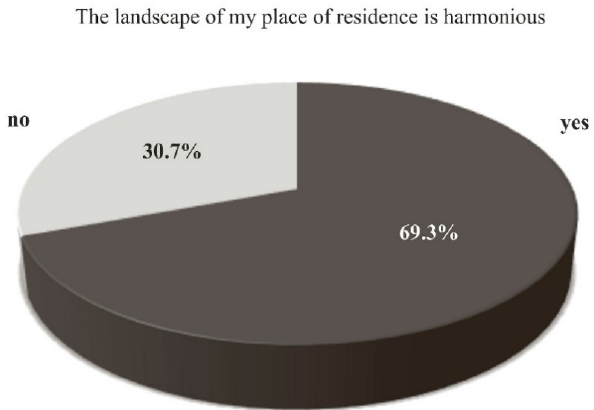
Figure 6. General assessment of the respondents of the landscape at their place of residence (EnvEng and CivEng students combined, n = 244).